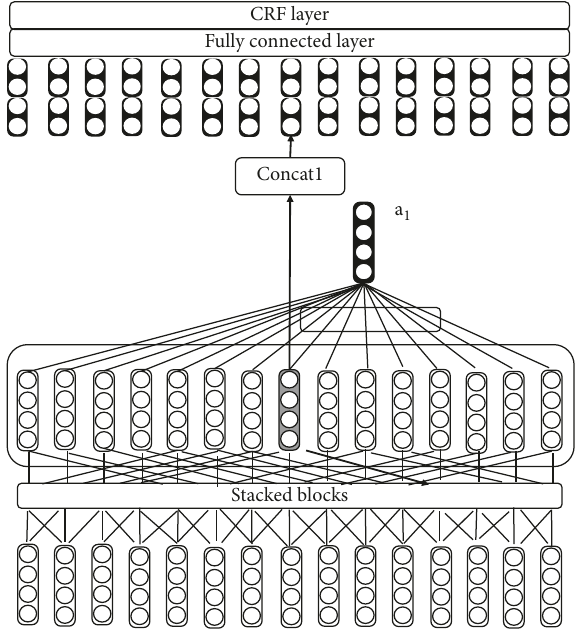
Figure 5: Attention-ID-CNN network model